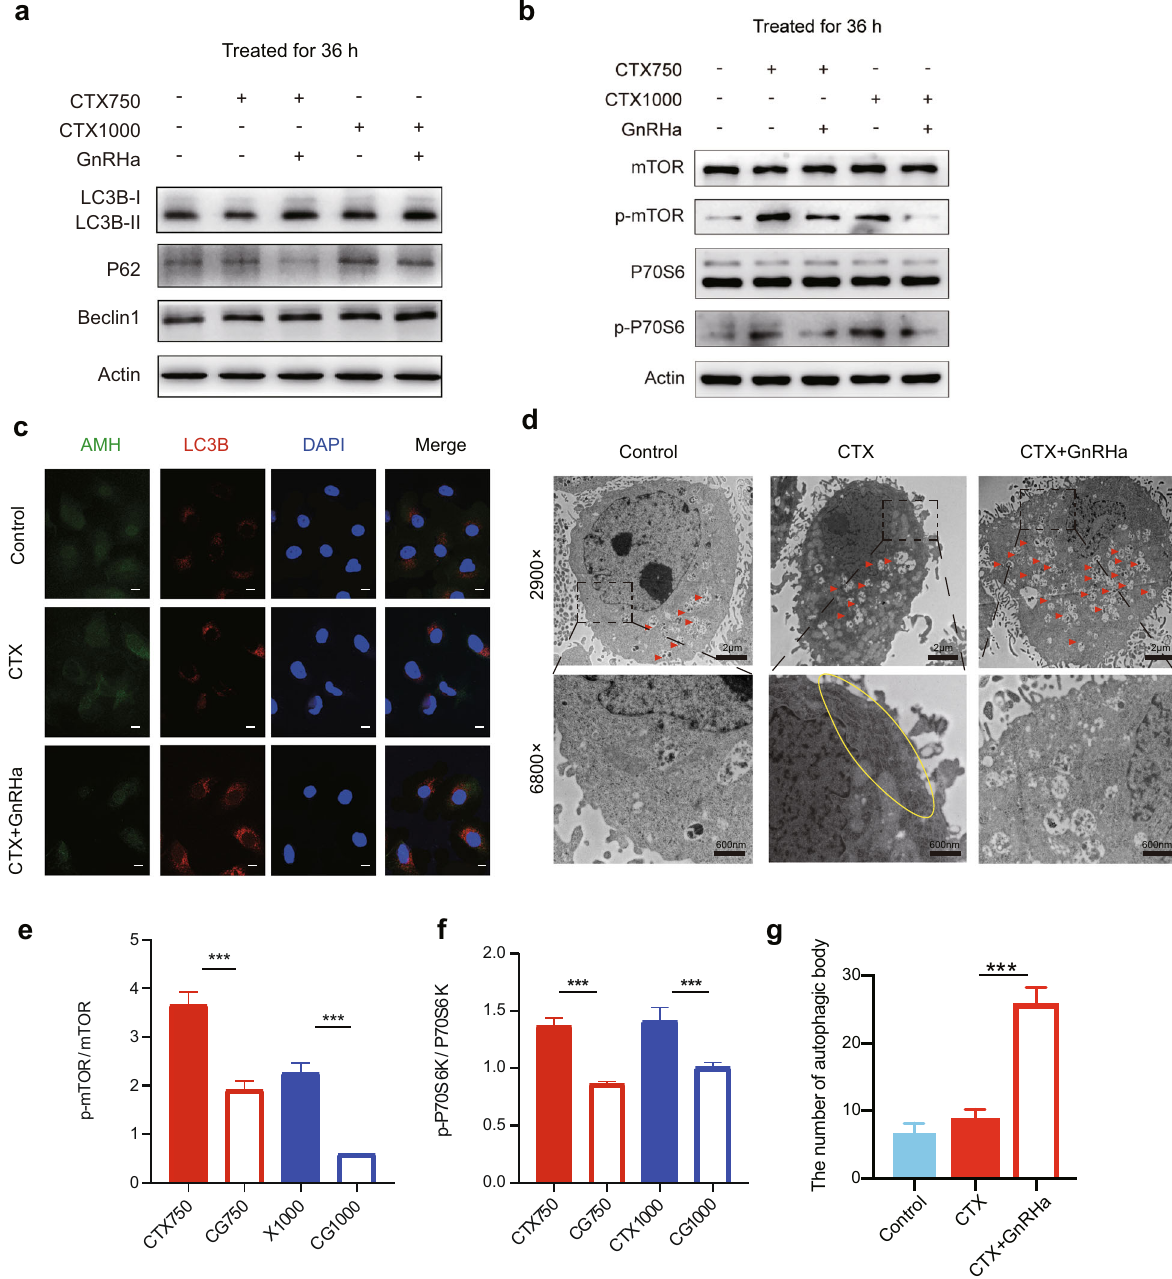
Fig. 6 GnRHa induces autophagy to relieve ER stress by inhibiting mTOR signaling. a Expression of proteins in autophagy was assessed by western blotting. Compared with CTX-treated cells, LC3B-II and Beclin-1 were higher, P62 were lower in cells co-treated with CTX and GnRHa. b Expressions of proteins in mTOR pathway were assessed by western blotting. c Typical immuno fl uorescence staining, indicating the localization of AMH and LC3B within KGN cells. Yellow in the merged images indicates the colocalization of AMH and LC3B. Nuclei were stained with DAPI. Scale bars represent 100 μ m. d , g Representative transmission electron microscopy results are shown for KGN cells treated with 750 µg/mL CTX, with or without GnRHa, for 36 h. Red arrowheads represent autophagic vacuoles; the yellow oval marks an area of ER stress. When the cells were co-treated with CTX and GnRHa, the numbers of autophagosomes appeared to be considerably higher. e , f Co- treatment with CTX and GnRHa reduced mTOR and P70S6K phosphorylation compared with CTX only. Compared with untreated control cells, the phosphorylation of mTOR and P70S6K were higher in the CTX-treated KGN cells. Data are expressed as mean ± SD of three independent experiments. Error bars show the standard error of the mean. Two-tailed Student ’ s t test was used for ( e , f ), two-way ANOVA (Tukey ’ s test) was used for g , * P < 0.05, ** P < 0.001, and *** P <